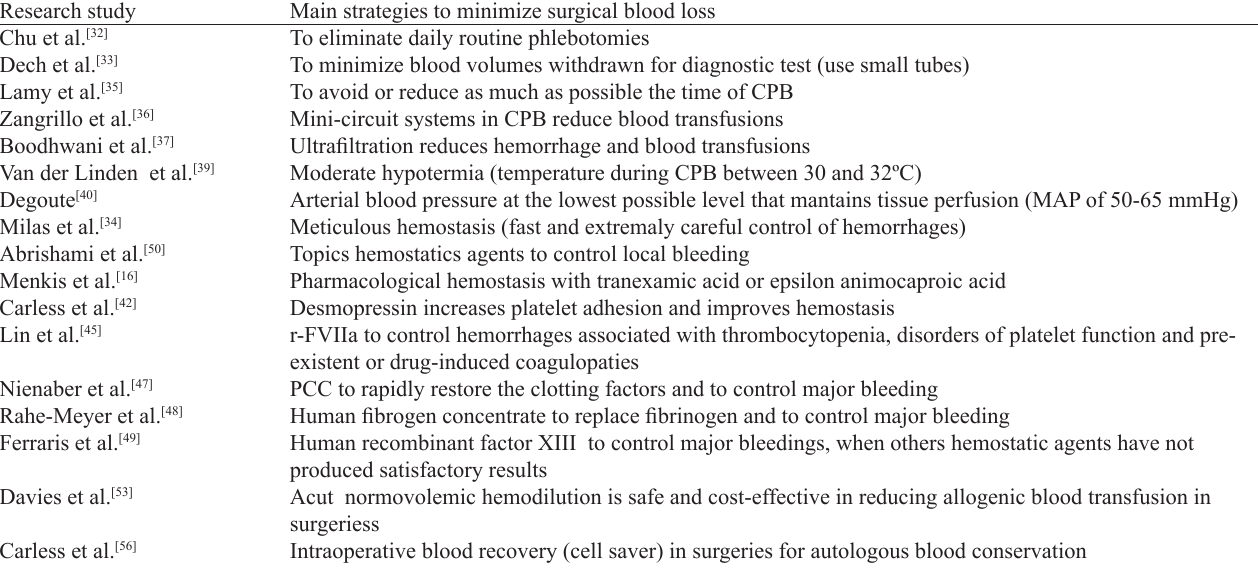
Table 2. Main strategies to minimize surgical blood